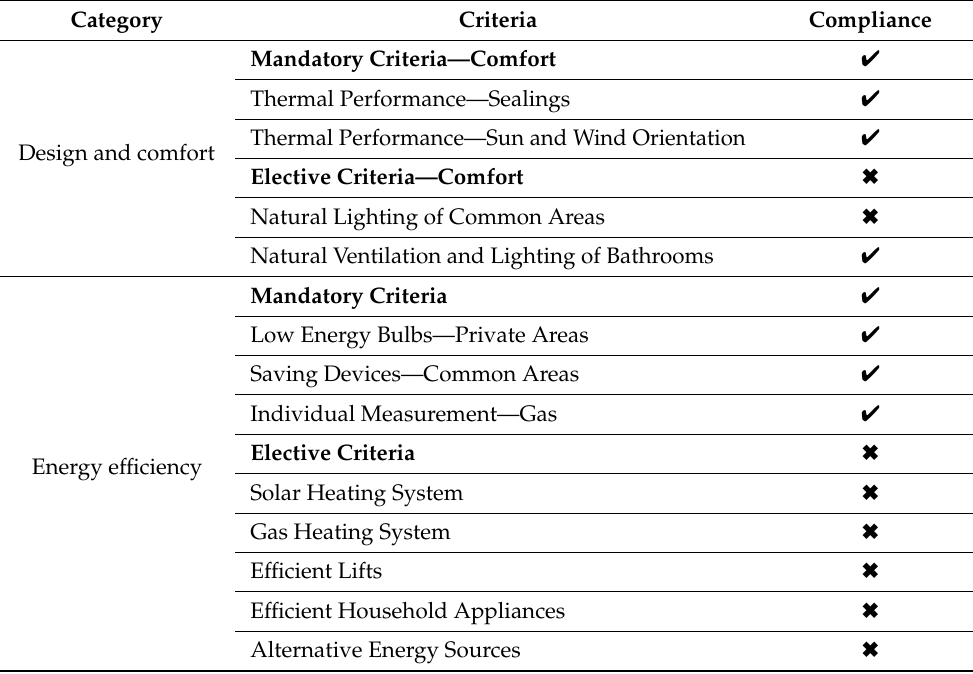
Table 2. Compliance of the residential with the CAIXA Selo Casa Azul certification. Category Criteria Compliance